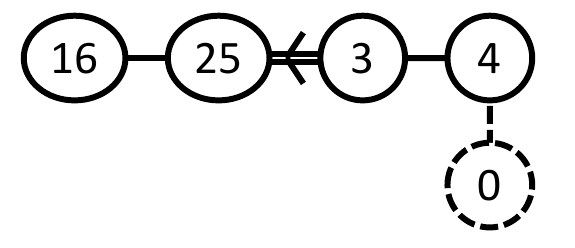
Figure 7 . The b F 4 Dynkin